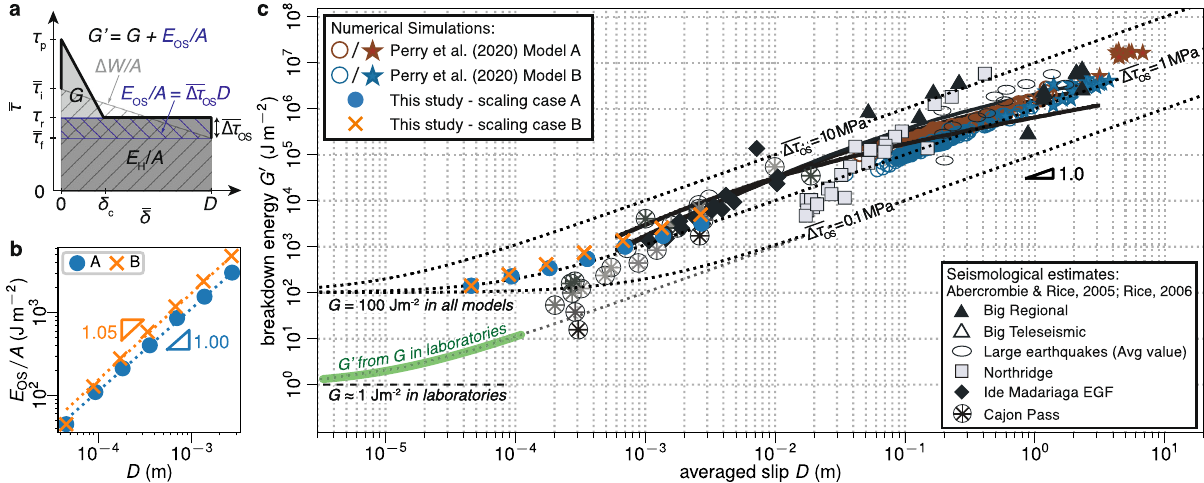
Fig. 3 Scaling relations of seismologically estimated breakdown energy G 0 . a Schematics of energy partition on the averaged stress versus averaged slip ( τ (cid:4) δ ) space, where the dark blue hashed area indicates the overestimation of fracture energy G by G 0 due to stress overshoot Δ τ lower than residual stress τ r . b The averaged overshoot energy E OS / A (Eq. (3)) is equivalent to G 0 (cid:4) G , which scales linearly with averaged slip D . c Comparison of G 0 from our models to data by ref. 1,3,9 . Three black dotted curves indicate G 0 computed by Eq. (2) with G = 100 Jm − 2 . The gray dotted curve diverged from the Δ τ OS ¼ 0 : 1MPa curve at the lower end of D highlights the G 0 expected in laboratories 21,56 and demonstrates that G is the lower limit of G 0 for Δ τ (cid:5) OS